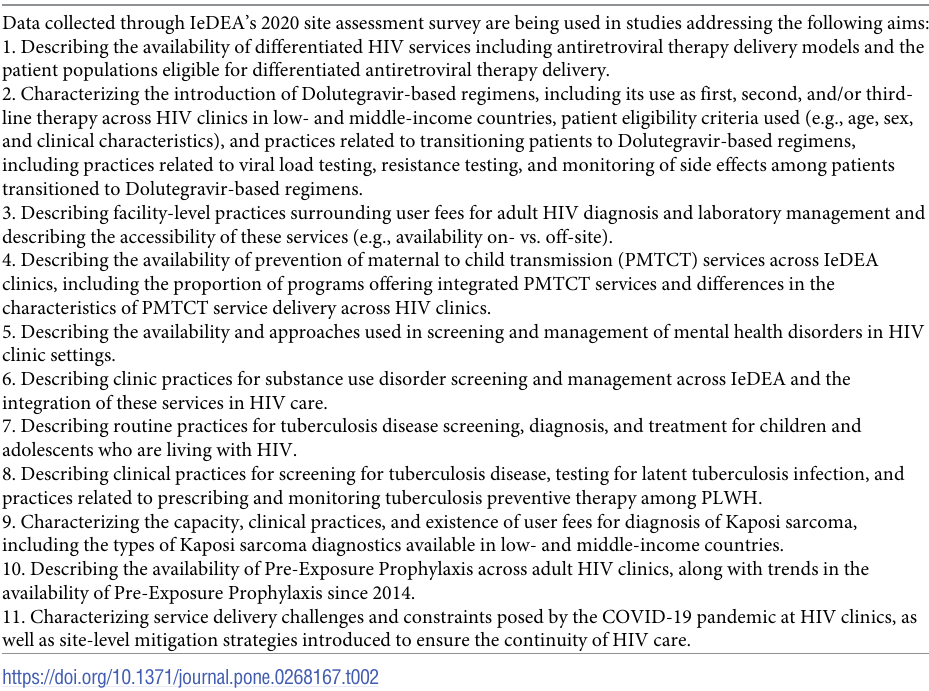
Table 2. Analyses using the IeDEA 2020 site assessment survey data. Data collected through IeDEA’s 2020 site assessment survey are being used in studies addressing the following aims: 1. Describing the availability of differentiated HIV services including antiretroviral therapy delivery models and the patient populations eligible for differentiated antiretroviral therapy delivery. 2. Characterizing the introduction of Dolutegravir-based regimens, including its use as first, second, and/or third- line therapy across HIV clinics in low- and middle-income countries, patient eligibility criteria used (e.g., age, sex, and clinical characteristics), and practices related to transitioning patients to Dolutegravir-based regimens, including practices related to viral load testing, resistance testing, and monitoring of side effects among patients transitioned to Dolutegravir-based regimens. 3. Describing facility-level practices surrounding user fees for adult HIV diagnosis and laboratory management and describing the accessibility of these services (e.g., availability on- vs. off-site). 4. Describing the availability of prevention of maternal to child transmission (PMTCT) services across IeDEA clinics, including the proportion of programs offering integrated PMTCT services and differences in the characteristics of PMTCT service delivery across HIV clinics. 5. Describing the availability and approaches used in screening and management of mental health disorders in HIV clinic settings. 6. Describing clinic practices for substance use disorder screening and management across IeDEA and the integration of these services in HIV care. 7. Describing routine practices for tuberculosis disease screening, diagnosis, and treatment for children and adolescents who are living with HIV. 8. Describing clinical practices for screening for tuberculosis disease, testing for latent tuberculosis infection, and practices related to prescribing and monitoring tuberculosis preventive therapy among PLWH. 9. Characterizing the capacity, clinical practices, and existence of user fees for diagnosis of Kaposi sarcoma, including the types of Kaposi sarcoma diagnostics available in low- and middle-income countries. 10. Describing the availability of Pre-Exposure Prophylaxis across adult HIV clinics, along with trends in the availability of Pre-Exposure Prophylaxis since 2014. 11. Characterizing service delivery challenges and constraints posed by the COVID-19 pandemic at HIV clinics, as well as site-level mitigation strategies introduced to ensure the continuity of HIV